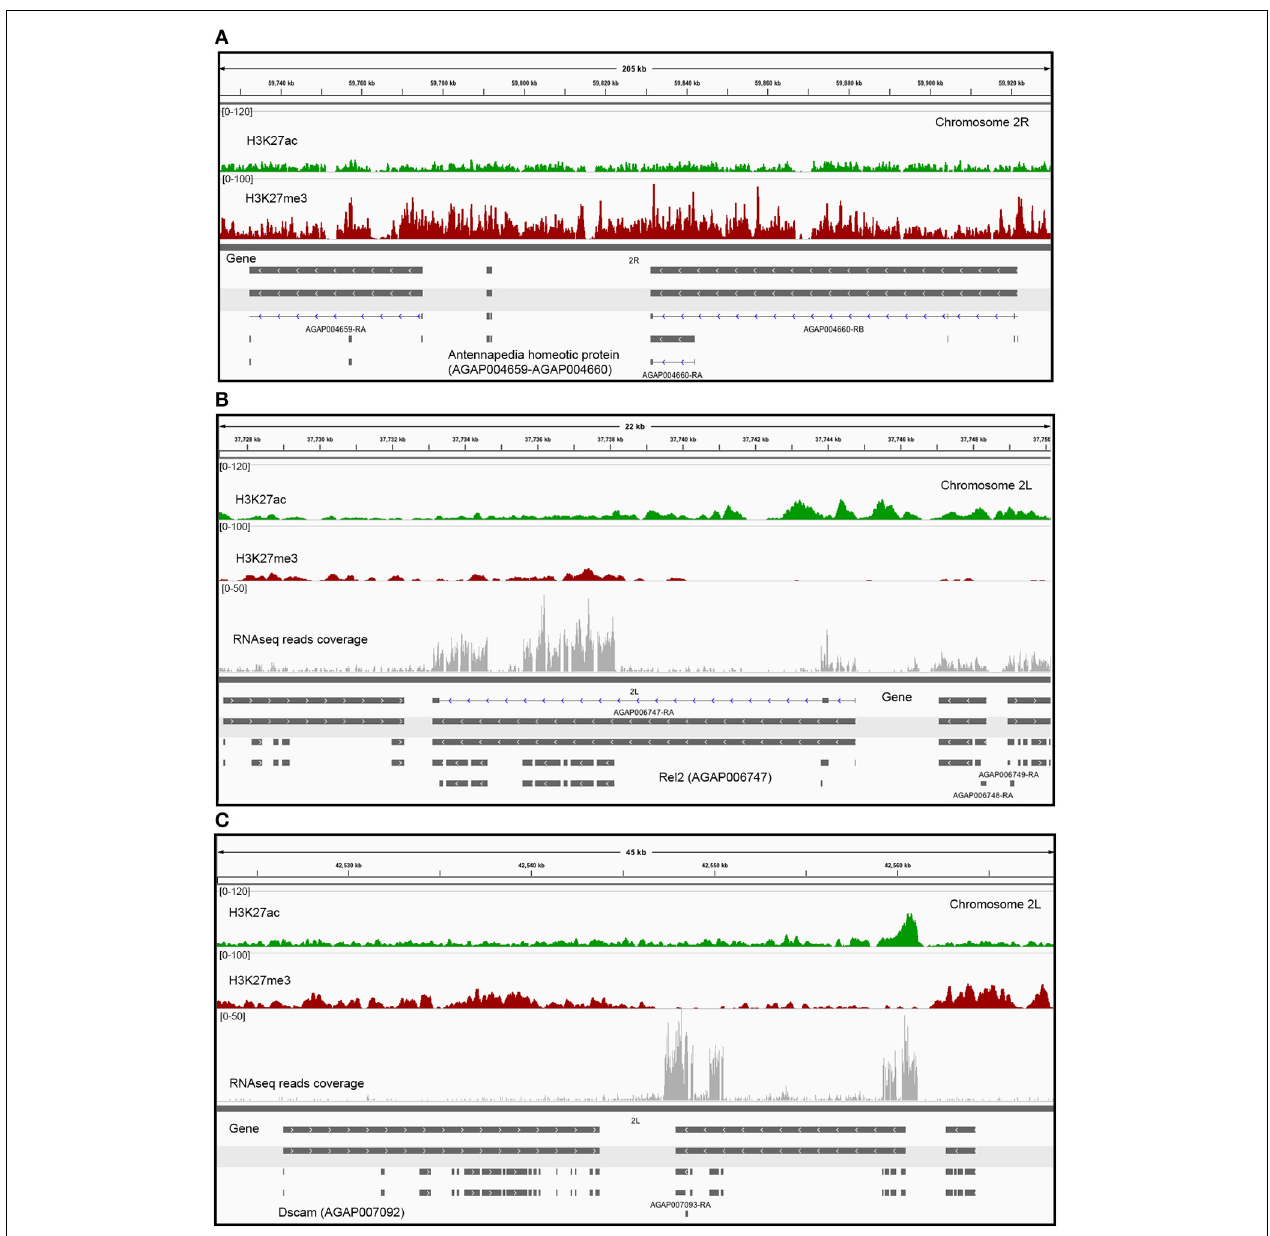
FIGURE 4 | Histone modification levels in selected genes. (A) Enrichment profile of histone PTMs in two Hox genes of A. gambiae (Antennapedia homeotic proteins, AGAP004659-AGAP004660). These are classic examples of Drosophila developmental genes where H3K27me3 is highly enriched and distributed in large domains that encompass both genic and intergenic regions in cells where the Antennapedia gene is silenced. Examples of